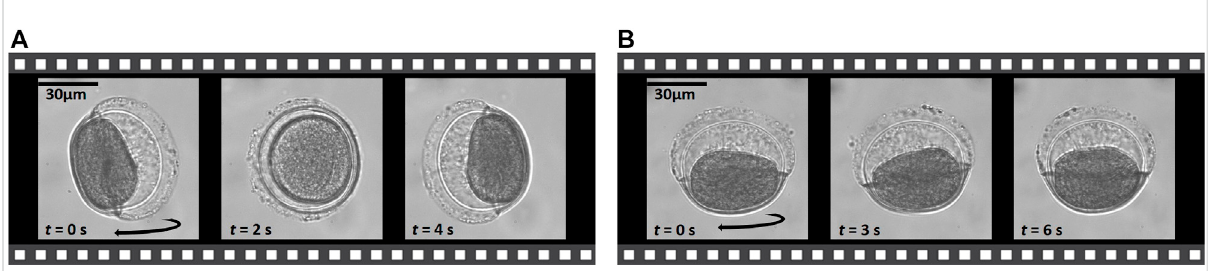
FIGURE 5 Sustained rotation aroundtwo orthogonal object axesallows one to collect tomographic data that cancircumventthe “ missing coneproblem ” when reconstructing the object. The timestamp of the selected images from the movie recording are shown in the lower left corner. (40× magni fi cation, NA obj = 0.75). Corresponding Supplementary Movies S3,